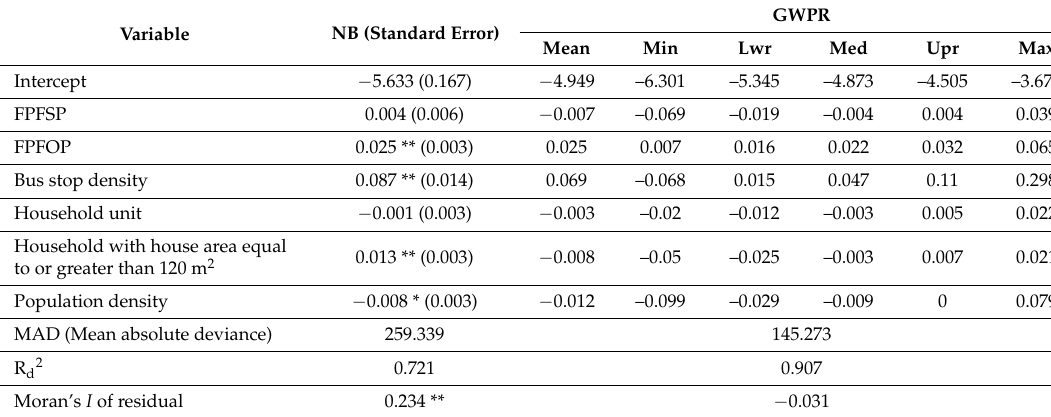
Table 3. Results of regression